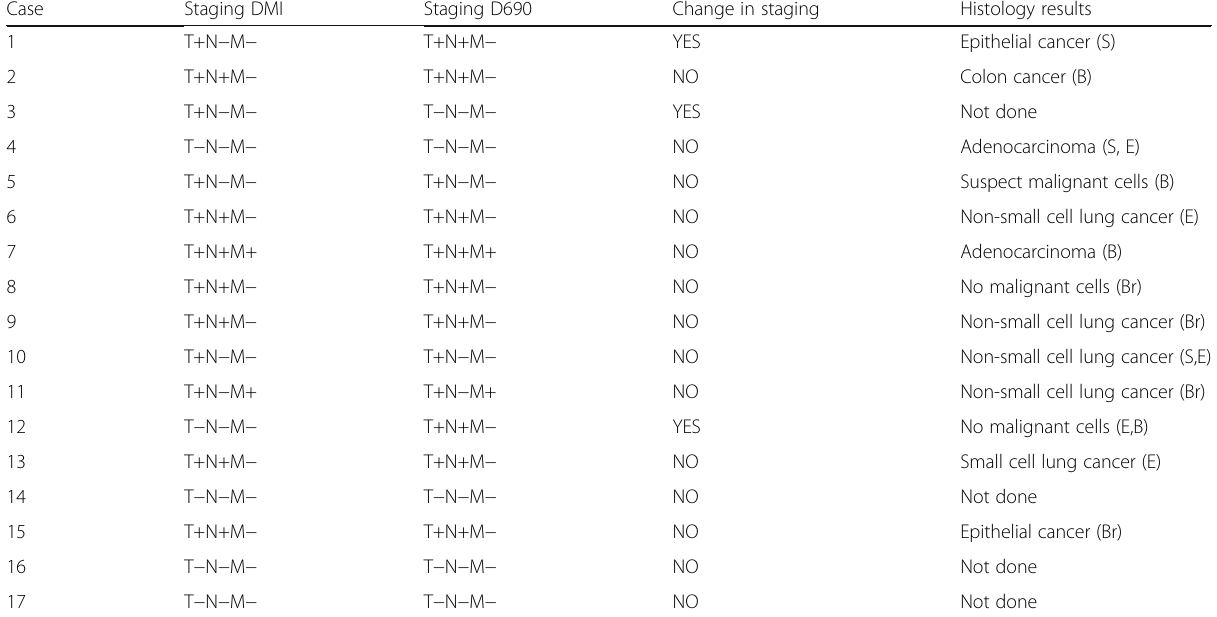
Table 4 Metabolic TNM stage based on the two PET examinations Case Staging DMI